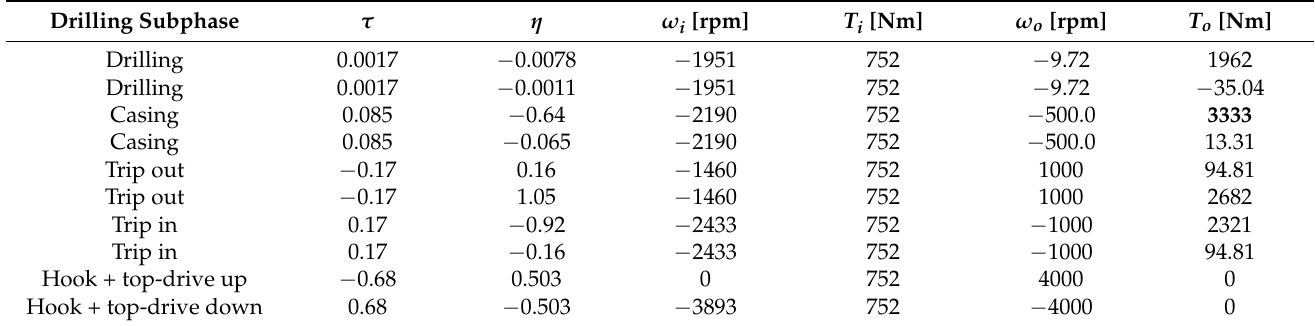
Table 7. MG I and MG O extreme operations for each drilling subphase with ICE working at 1400 rpm and 1045 Nm. MG O torque values exceeding the maximum torque of 3008 Nm are bolded.